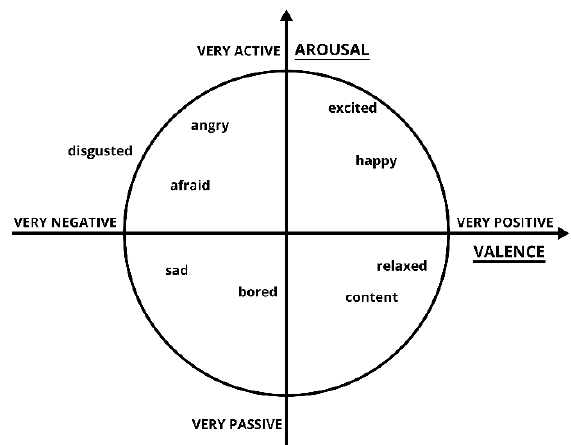
Figure 1. The circumplex model of affect in the valence–arousal space. Adapted from [10].